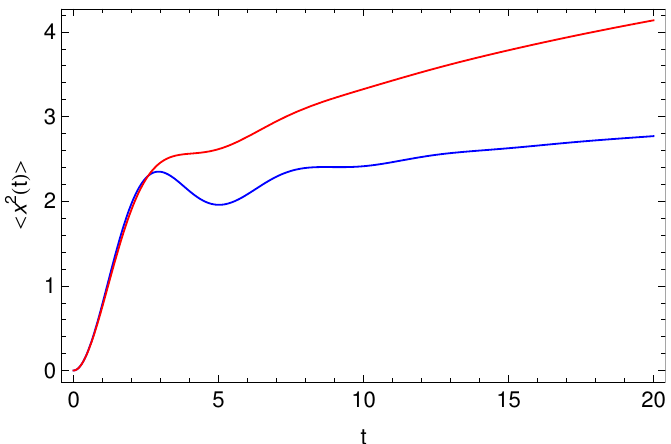
Figure 1. Graphical representation of the MSD (30) for k B T = 1, γ µ , ρ , δ = 1, τ = 1, ρ = 1/2, δ = 3/4, and µ = 1/2 (blue line), µ = 5/8 (red